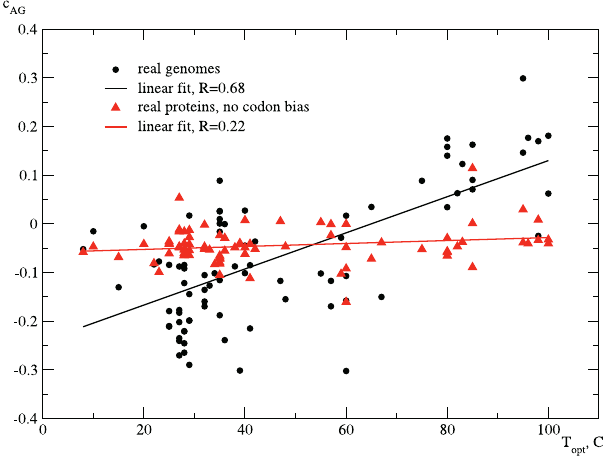
Figure 8. Dependence of the Pairwise Nearest-Neighbor Correlation Function for A,G Nucleotides c AG on the OGT in the Genomes of 83 Species (Black) and in the DNA Sequences Obtained from the Proteomes of 83 Species without Codon Bias (Red) While codon bias is not essential for reproducing the trends in nucleotide composition (Figure 6), nucleotide correlations are entirely dependent on the proper choice of codon bias. An increase of the number of ApG dinucleotides enhances the stacking interactions in DNA, stabilizing it at elevated environmental temperatures.